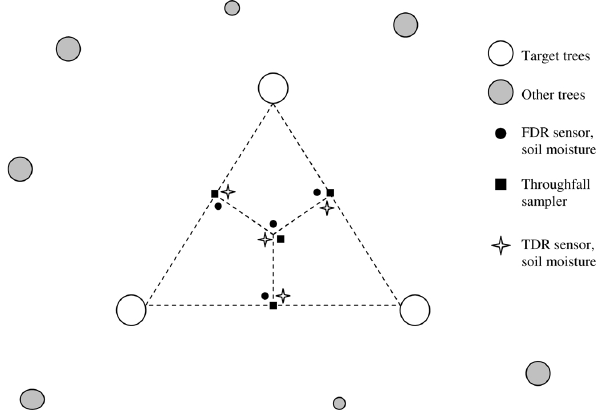
Figure 2. Schematic study plot design (tree cluster) with locations of FDR, TDR sensors and throughfall